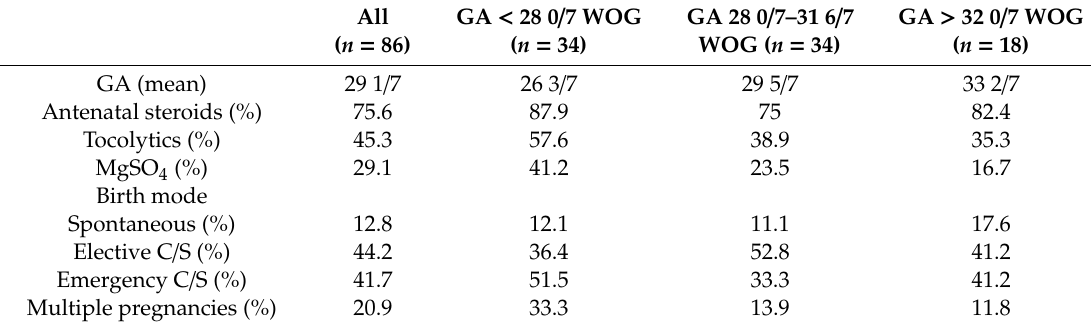
Table 2. Maternal characteristics of the study